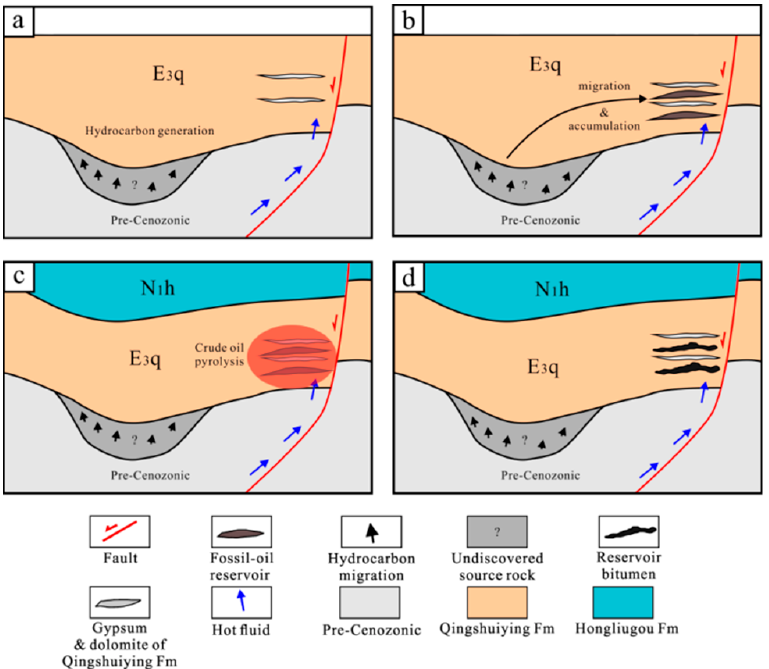
Figure 8. Formation of the fossil oil reservoir and reservoir bitumen in Yinchuan Graben. ( a ) Undis- covered source rocks generated oil. At the same time, the hydrothermal fluids from the mantle moved upward along the deep faults. But the ground temperature was not sufficient for the pyrolysis of crude oil; ( b ) The oil generated from undiscovered source rock migrated and formed fossil-oil reservoirs in the traps formed by gypsum in the Qingshuiying Formation; ( c ) As the thickness of overlying sedimentary strata increased and the hydrothermal fluids heated the strata, the ground temperature rised and leaded to the pyrolysis of fossil-oil reservoirs; ( d ) The pyrolysis of fossil-oil reservoirs formed reservoir bitumen.